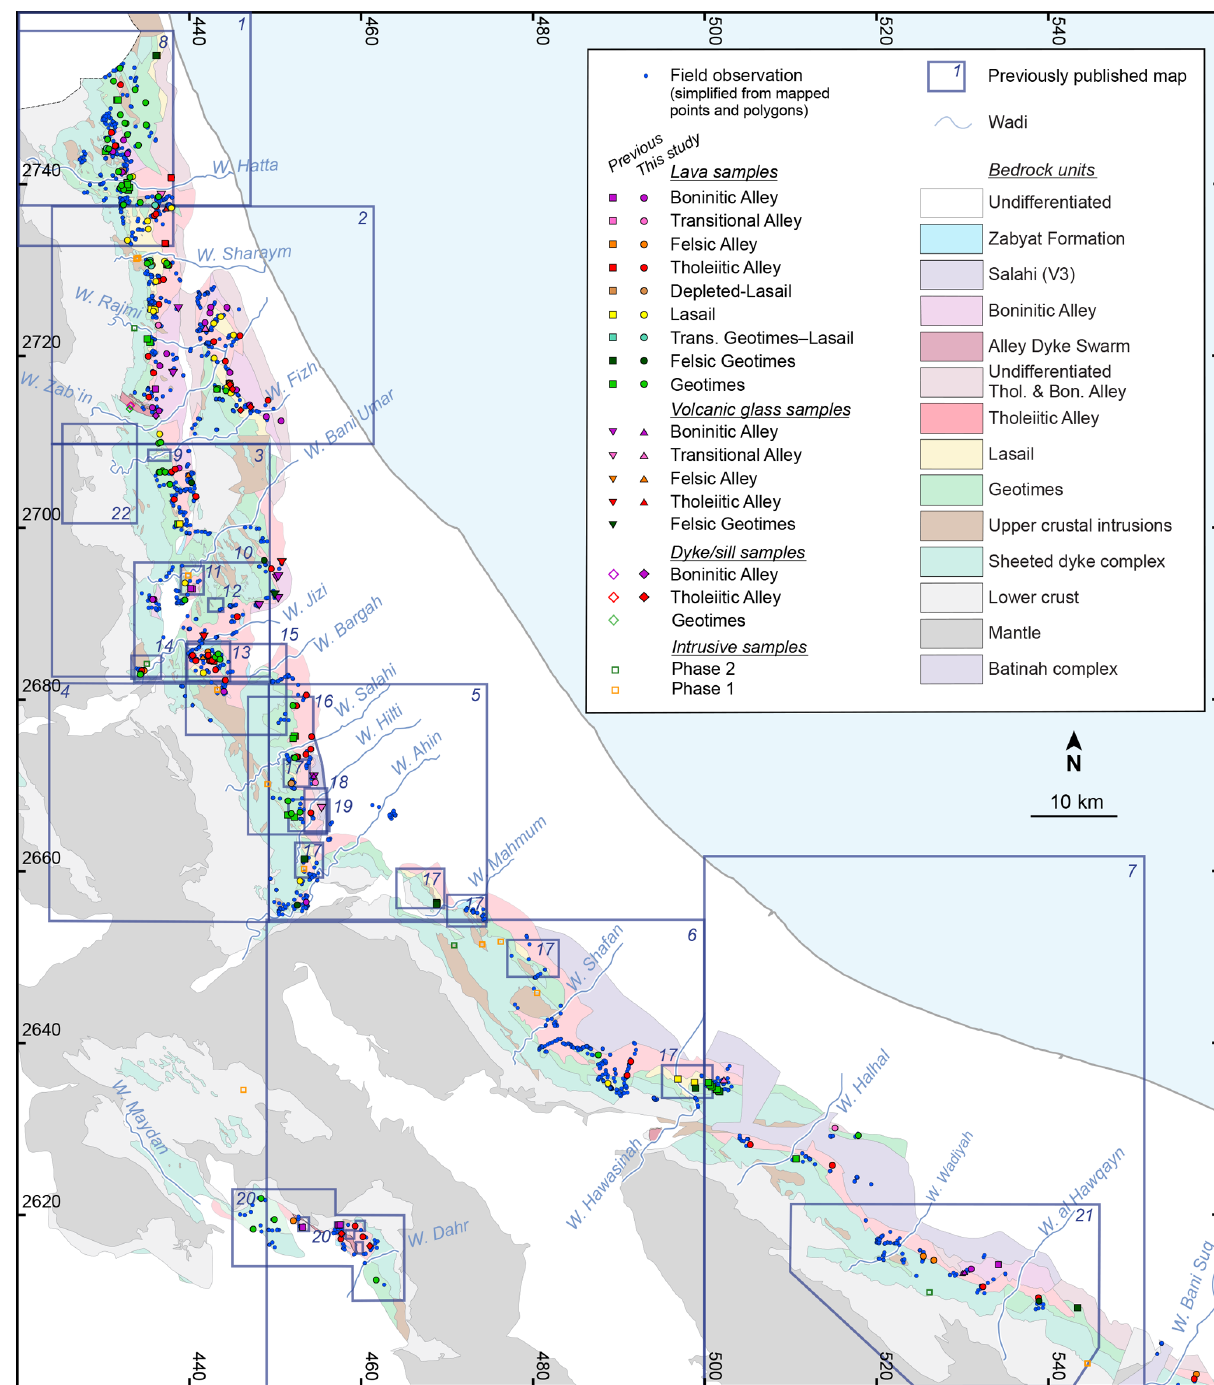
Figure 11. Summary of datasets used to construct the final map in addition to the aeromagnetic survey in Fig. 10. Red circles: field mapping locations (this study). Reference samples include triangles: volcanic glasses (this study); filled diamonds: dykes and sills (this study); unfilled diamonds: dyke samples from Adachi and Miyashita (2003); squares: lava and volcanic glass samples from Gilgen et al. (2014, 2016), Kusano et al. (2017), and MacLeod et al. (2013); unfilled squares: P1 and P2 intrusive samples from Haase et al. (2016) and de Graaff et al. (2019). Numbered outlines: coverage of previous publications used to support our mapping: (1) BRGM (1993b), (2) BRGM (1993a), (3) BME (1987a), (4) BME (1987c), (5) BME (1987b), (6) BRGM (1986b), (7) BRGM (1986a) and local maps, (8) Reuber (1988), (9) Kusano et al. (2012), (10) Umino et al. (2003), (11) Haymon et al. (1989), (12) A’Shaikh et al. (2005), (13) Alabaster et al. (1980), (14) Robertson and Woodcock (1983), (15) Alabaster and Pearce (1985), (16) Ernewein et al. (1988), (17) JICA (2000), (18) Umino (2012), (19) Kusano et al. (2014), (20) JICA (2002), (21) Reuber et al. (1991), and (22) Adachi and Miyashita (2003). www.solid-earth.net/10/1181/2019/ Solid Earth, 10, 1181–1217,